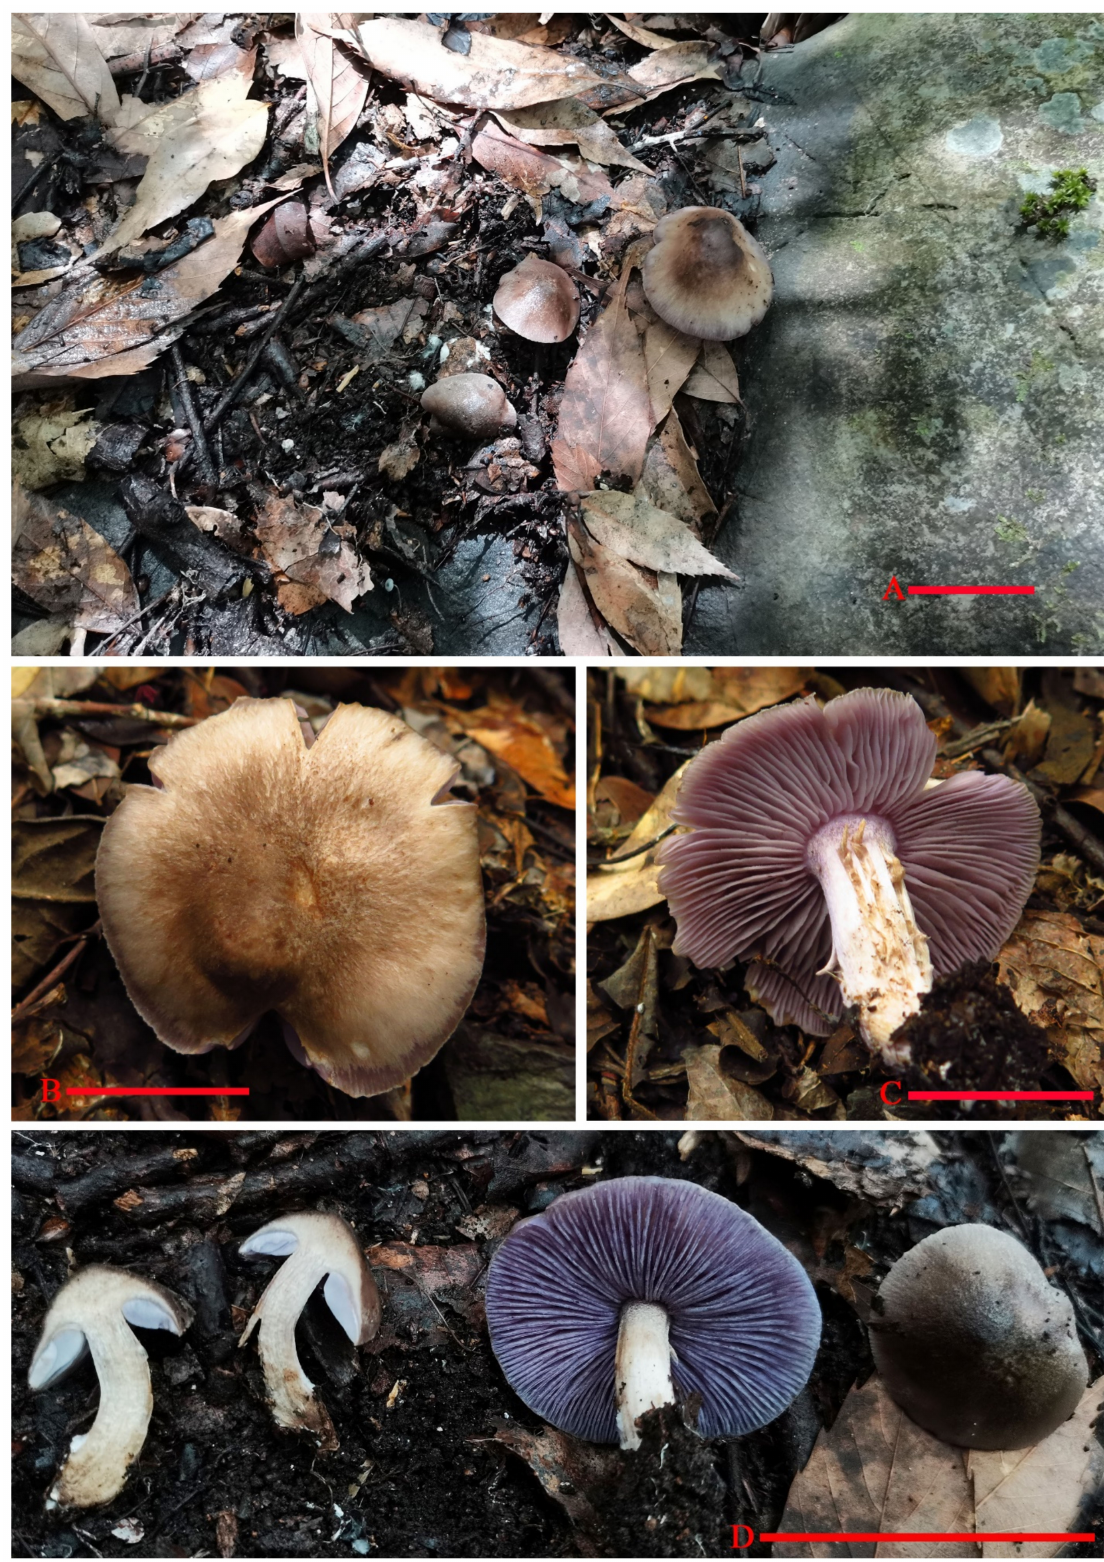
Figure 3. Basidiomata of Asproinocybe sinensis . Scale bar ( A , D ) = 5 cm; B, C = 2.5 cm. ( A , D ) from HMJAU59025 (Holotype HMJAU); ( B , C ) from M2020081289 (IBK!). Photos by Guang-fu